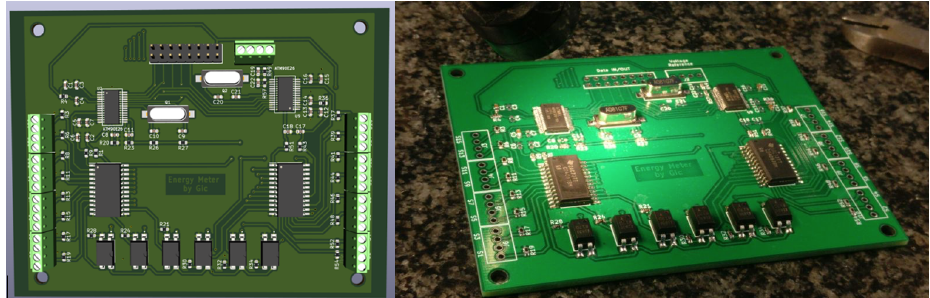
Figure 8. Final design of the PCB. ( Left side ) PCB rendering. ( Right side ) Real